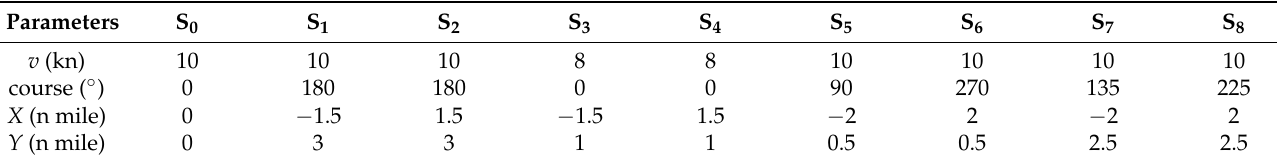
Table 4. Ship collision risk based on